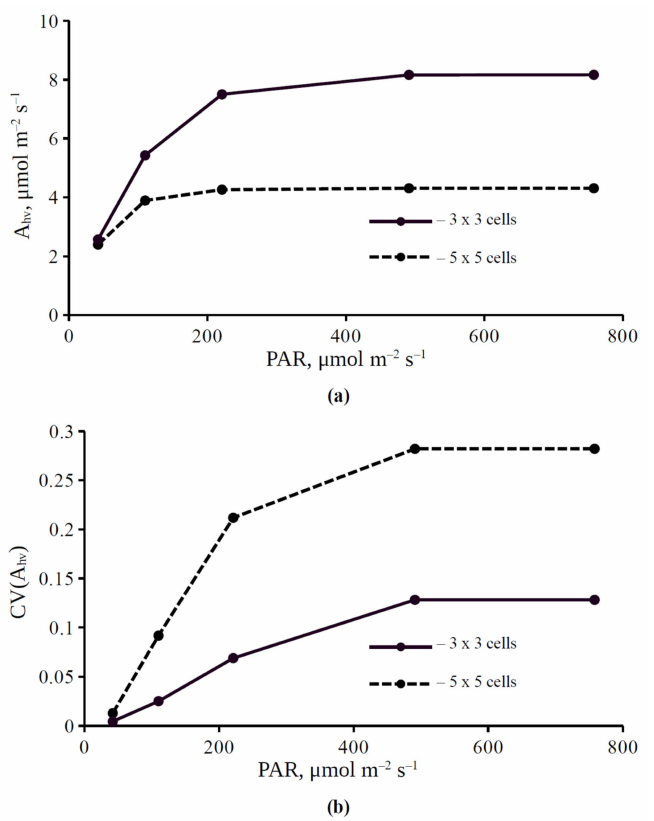
Figure 2. Light dependence of the photosynthetic CO 2 assimilation rate A hv ( a ) and the coefficient of variation of assimilation CV(A hv ) ( b ). PAR is photosynthetically active radiation. Each stomata in the simulated leaf was located in center of a 3 × 3 cell square or a 5 × 5 cell square. The basic values of the model parameters were